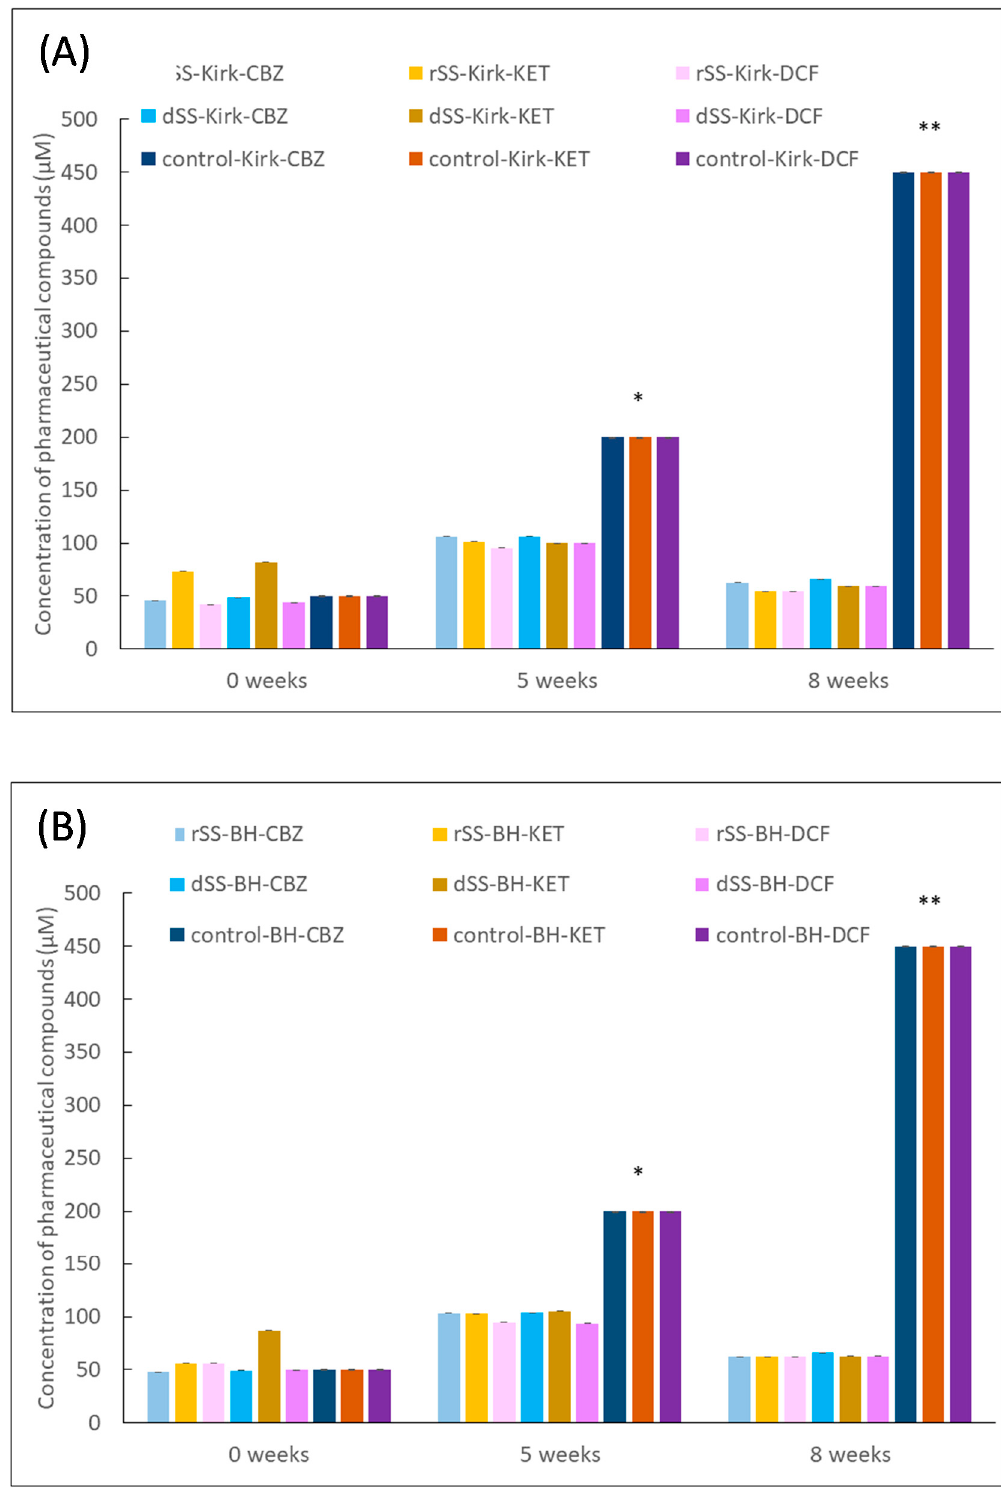
Figure 4. Overall concentration of PhACs ( µ M) after eight weeks of enrichment experiment with raw (rSS) and digested sewage sludge (dSS) in ( A ) modified Kirk medium and ( B ) BH medium. Mean values of triplicate measurements were calculated, 1 bar = standard deviation (n = 3). Num- ber of asterisks (*, **) indicated significant differences p < 0.05 calculated by three-way ANOVA (Sigmaplot